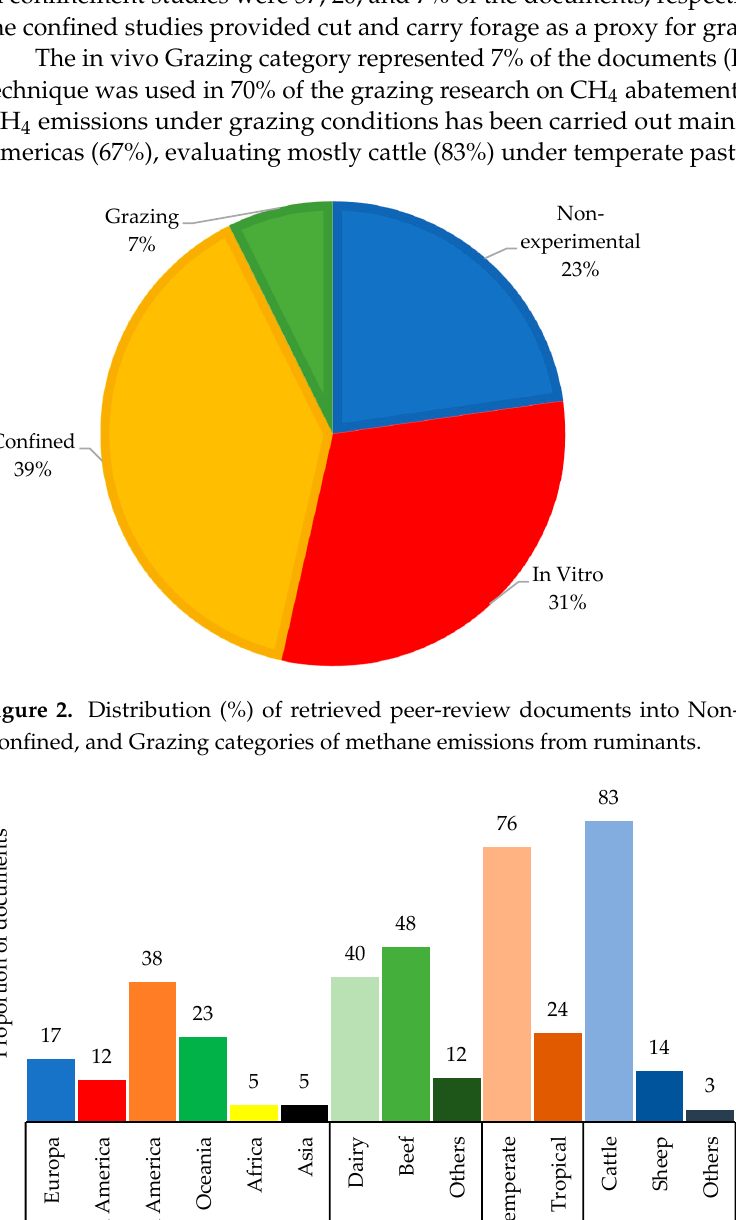
Figure 1. Publishing decade of retrieved peer-review documents of enteric methane emissions from ruminants.